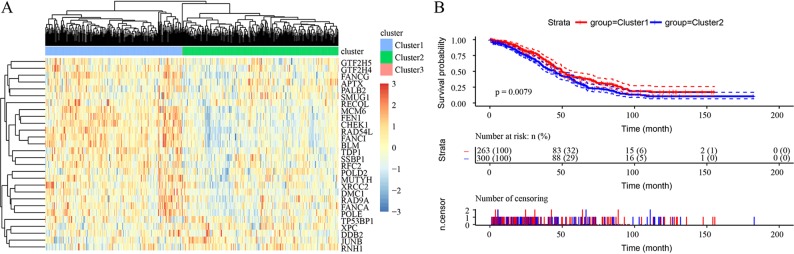
Unsupervised clustering based on 28 prognostic DNA repair genes from the TCGA HT_HG-U133A data set. (A) Heatmaps of 3 clusters divided by the expression of 28 prognostic DNA repair genes. (B) The prediction of prognosis between different clusters.